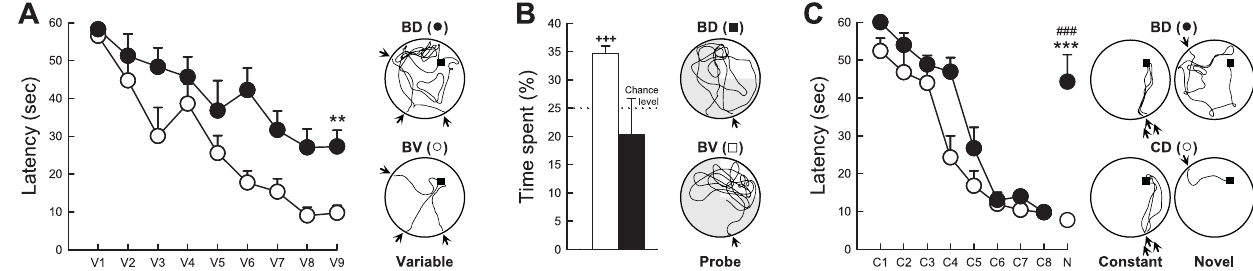
Figure 6. Effects of adult hippocampal neurogenesis ablation on spatial navigation. ( A ) Latency to reach the hidden platform using variable start positions. Right: representative swim paths during the last training day (V9) for a bigenic mouse treated with Dox (BD) and a bigenic mouse treated with vehicle (BV). ( B ) Time spent in the target quadrant during the probe test. Right: representative swim paths during the probe test. ( C ) Latency to reach the hidden platform using constant (C1 to C8) or novel (N) start positions. Right: representative swim paths during constant (C8) and novel (N) start position training days. BV=bigenic-vehicle mice; BD=bigenic-Dox mice; CD=control-Dox mice. ### : p # 0.001 compared to C8; **: p # 0.01, ***: p # 0.001 compared to the control group; +++ : p # 0.001 compared to chance level. Black arrows indicate start point